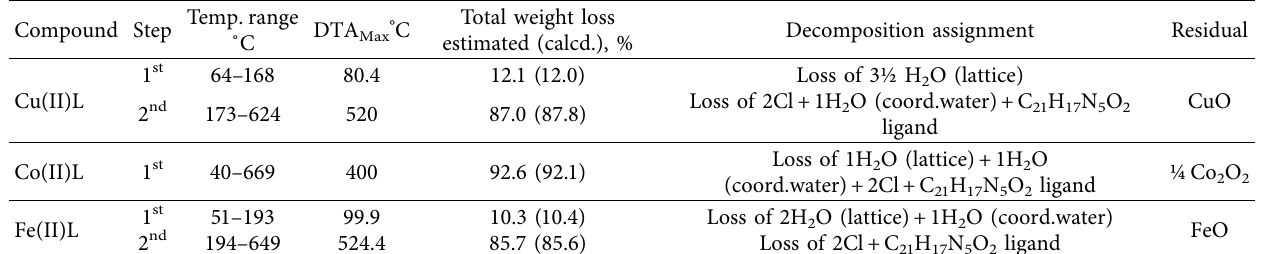
Decomposition assignment